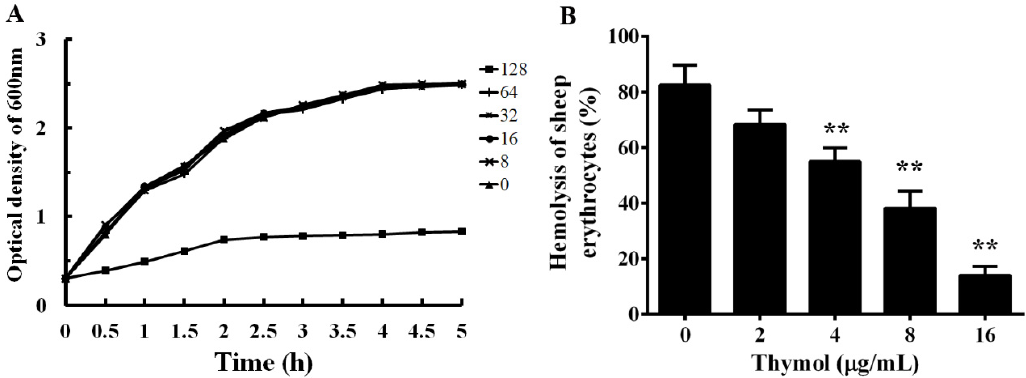
Figure 2. Influence of thymol on the growth and hemolytic activity of A. hydrophila . A , growth curves of A. hydrophila co-cultured with di ff erent concentrations of thymol in BHI medium. B, Hemolytic activity of A. hydrophila supernatants co-cultured with indicated concentrations of thymol; sheep erythrocytes treated with Triton X-100 served as the positive control. All the data in Figure 2B are shown as mean value ± SD of three independent assays, *, 0.01 < p < 0.05 and **, p < 0.01 compared with thymol ‐ free culture.